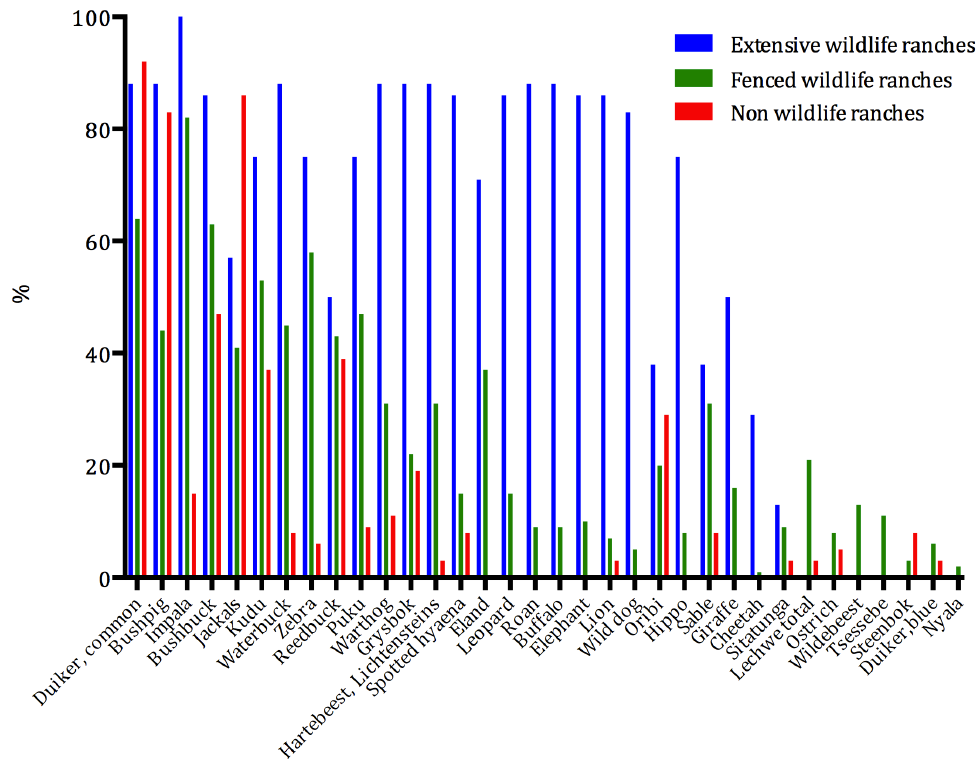
Figure 2. The percentage occurrence of ungulate and large predator species on Zambian ranches.